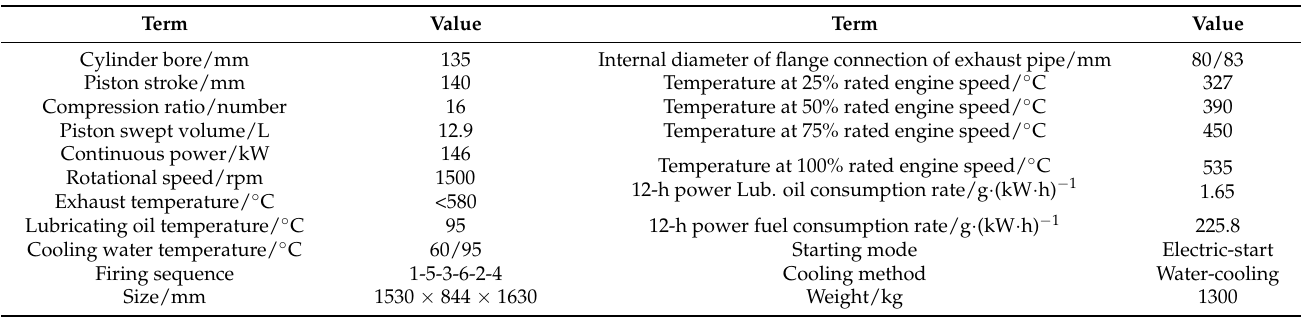
Table 1. 6135G128ZCa diesel engine parameters.